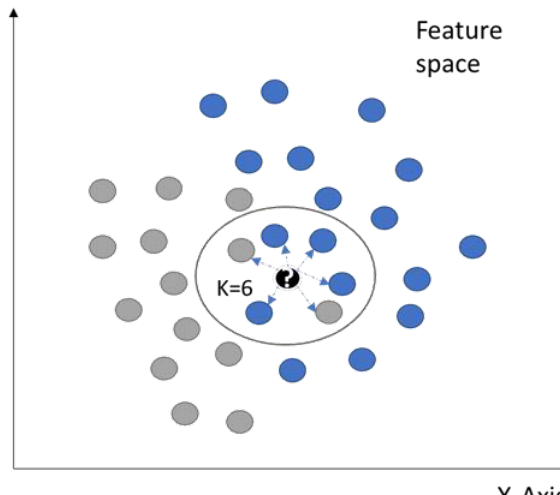
Figure 4. Classification scenario using a K-NN algorithm.